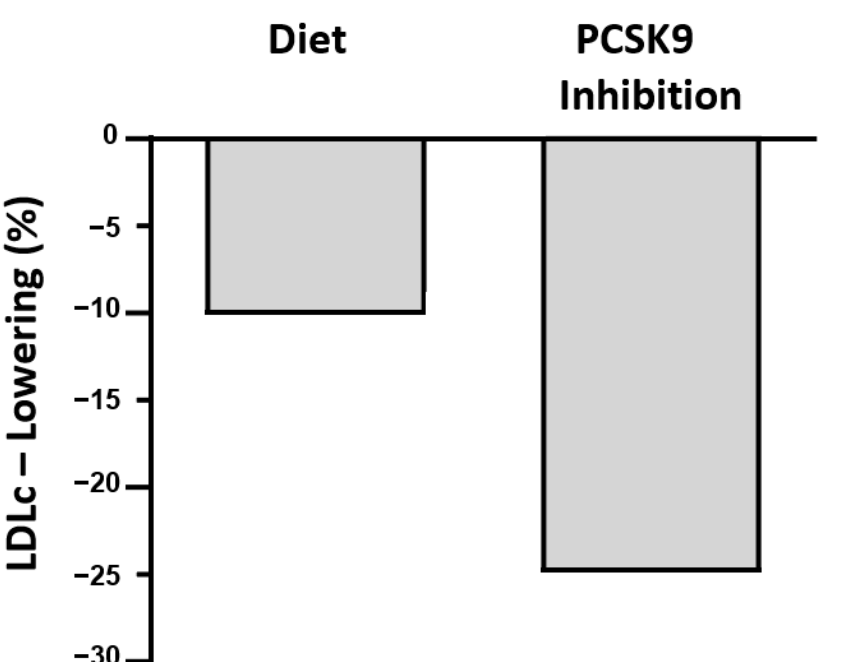
Figure 1. Illustrative depiction of relative LDLc lowering by diet and pharmacotherapy (as referenced in text).